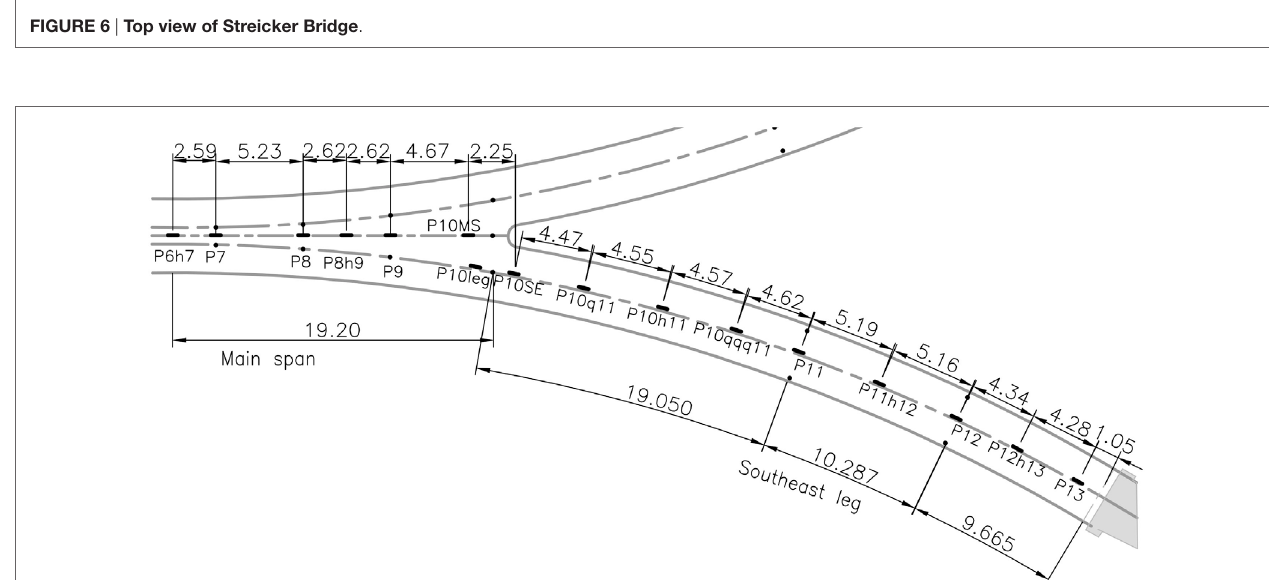
FIGURe 7 | top view of streicker Bridge with sensor locations along the main span and the southeast leg (sigurdardottir et al., 2012) .